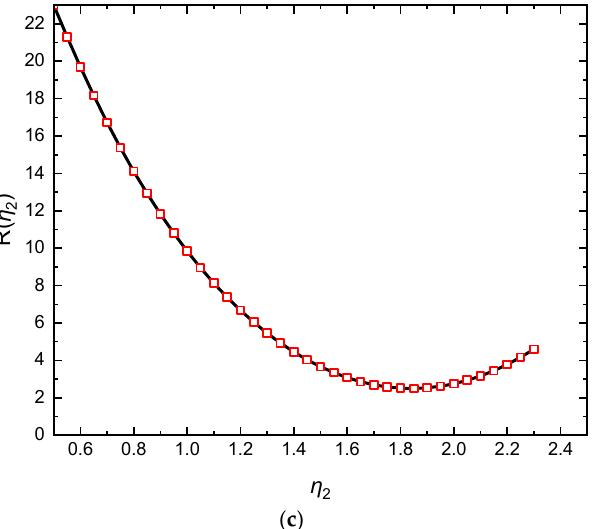
Figure 11. Relationship between η 2 and the minimum variance R ( η 2 ) for the ( a ) T1, ( b ) T2, and ( c ) T3 energy levels.